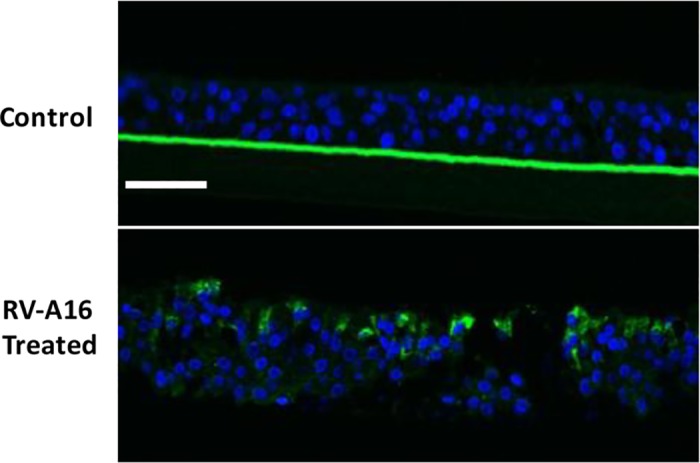
ALI cultured HAECs were infectible by RV-A16.Immunofluorescence micrographs of transverse sections of ALI cultures shows RV-A16 replicated in ALI cultured HAECs. Positive immunofluorescence staining for mabj2 (in green) was not observed in uninfected control tissues (top panel), but was observed in RV-A16 infected tissues (bottom panel); DAPI staining in blue shows cell nuclei in the tissues. Scale bars: 50 μm.